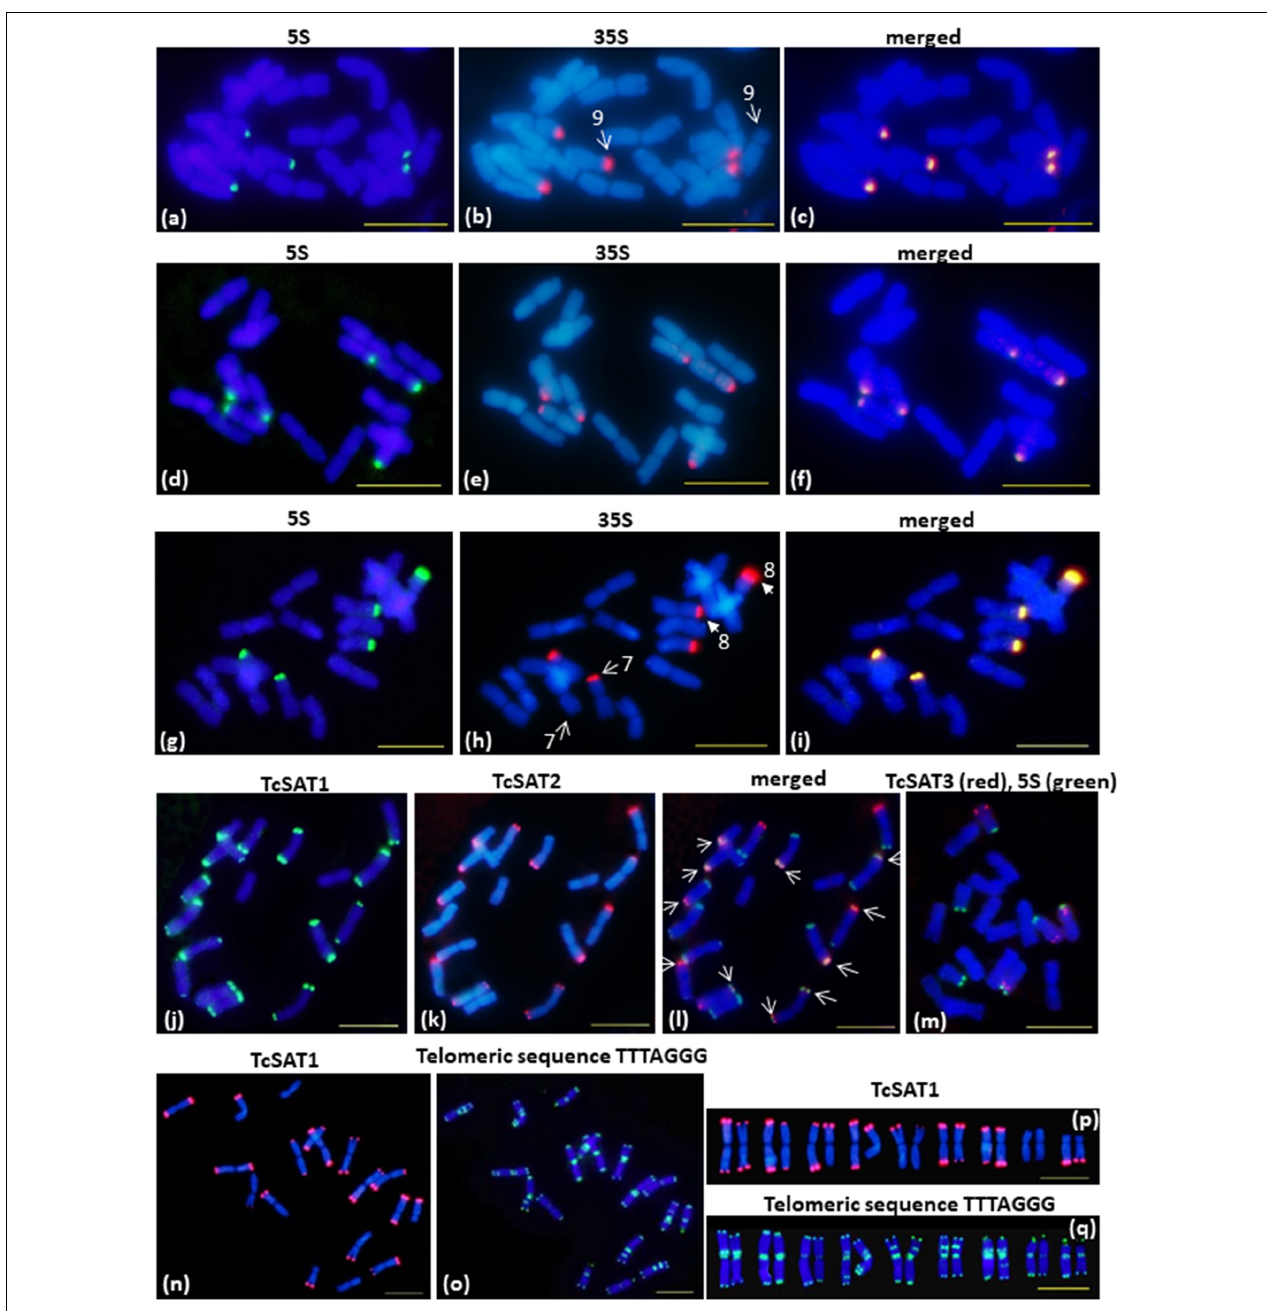
FIGURE 2 | FISH mapping of 35S/5S rDNA, TcSAT1, TcSAT2 and TcSAT3 satellite DNA repeats and Arabidopsis -type (TTTAGGG) n telomeric repeats on somatic metaphase chromosomes of Tanacetum cinerariifolium (2 n = 18). (a–i) FISH on metaphase chromosomes that evolved linked arrangement of rRNA genes. (a–c) accession 20-7 and (g–i) accession 2158-4 have five linked 5S/35S rDNA sites. (d–f) accession 53-3 has six linked 5S/35S rDNA sites. Arrows on (b,h) mark heteromorphic chromosome pairs 9 and 7 and 8, respectively. The 35S and 5S rDNA loci are labeled in green and red, respectively. (j–l) FISH mapping of TcSAT1 (green) and TcSAT2 repeats (red). Overlapped TcSAT1 and TcSAT2 signals are marked with arrows. (m) FISH mapping of TcSAT3 repeat family (red) and 5S rDNA (green). (n–q) FISH mapping of the TcSAT1 (red) and Arabidopsis -type plant telomeric DNA probe (green). (j–l), (n–q) accession 53-3. (m) accession 2158-5. Scale bar, 10 µ